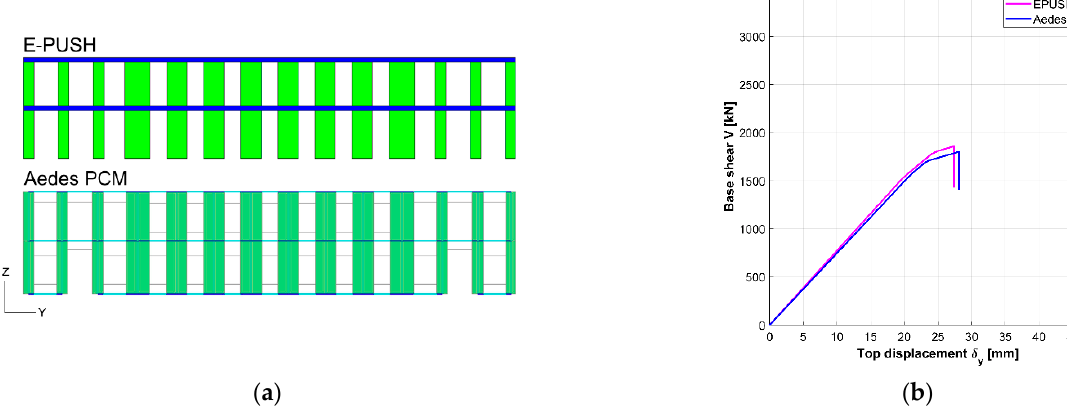
Figure 12. Comparison of capacity curves provided by Aedes PCM and E-PUSH for the wall alignment No. 7 in Figure 9: ( a ) model of the wall alignment, ( b ) capacity curves.